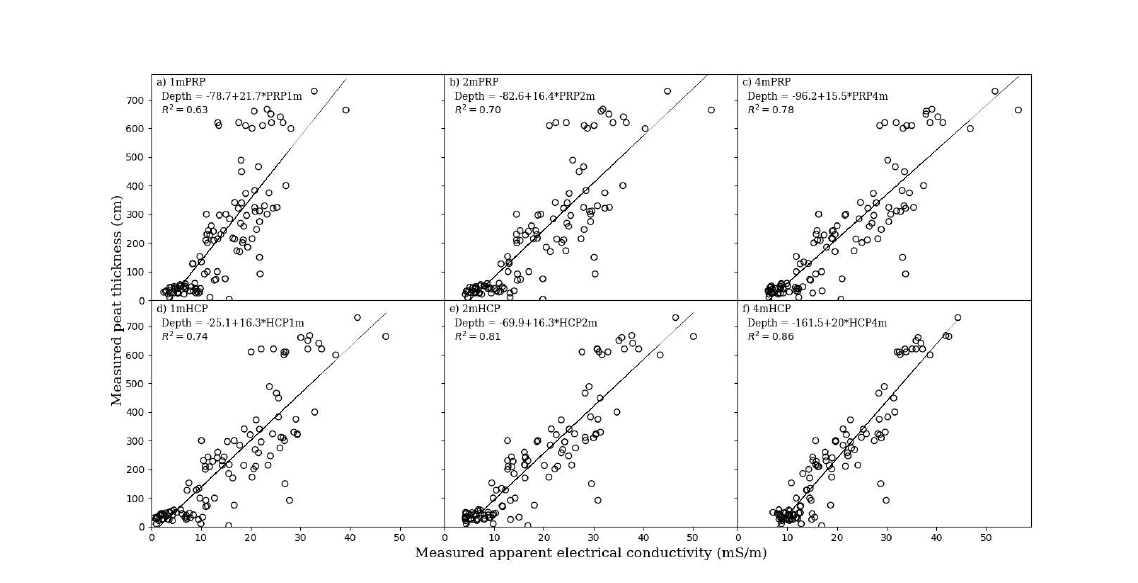
Figure 6. Measured peat thickness (cm) vs. measured apparent electrical conductivity (EC a —mS/m) collected using the six different coil configurations of a DUALEM-421S instrument: ( a ) 1mPRP, ( b ) 2mPRP, ( c ) 4mPRP, ( d ) 1mHCP, ( e ) 2mHCP and ( f ) 4mHCP (fitted regression line represented on each plot).